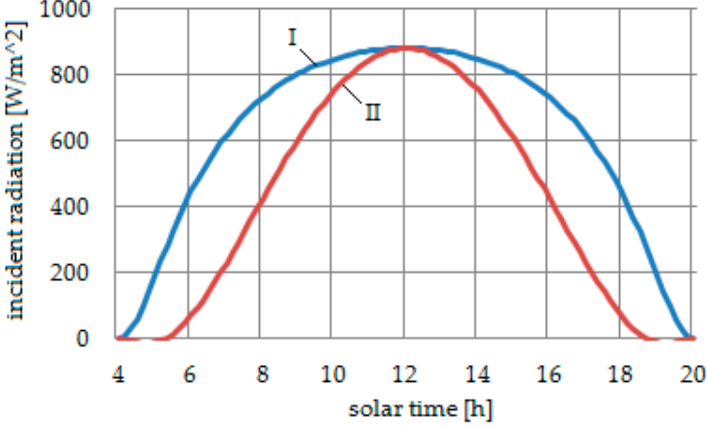
Figure 13. Incident radiation corresponding to the continuous tracking (I) and to the system kept fixed (II) on summer solstice day (21 June).